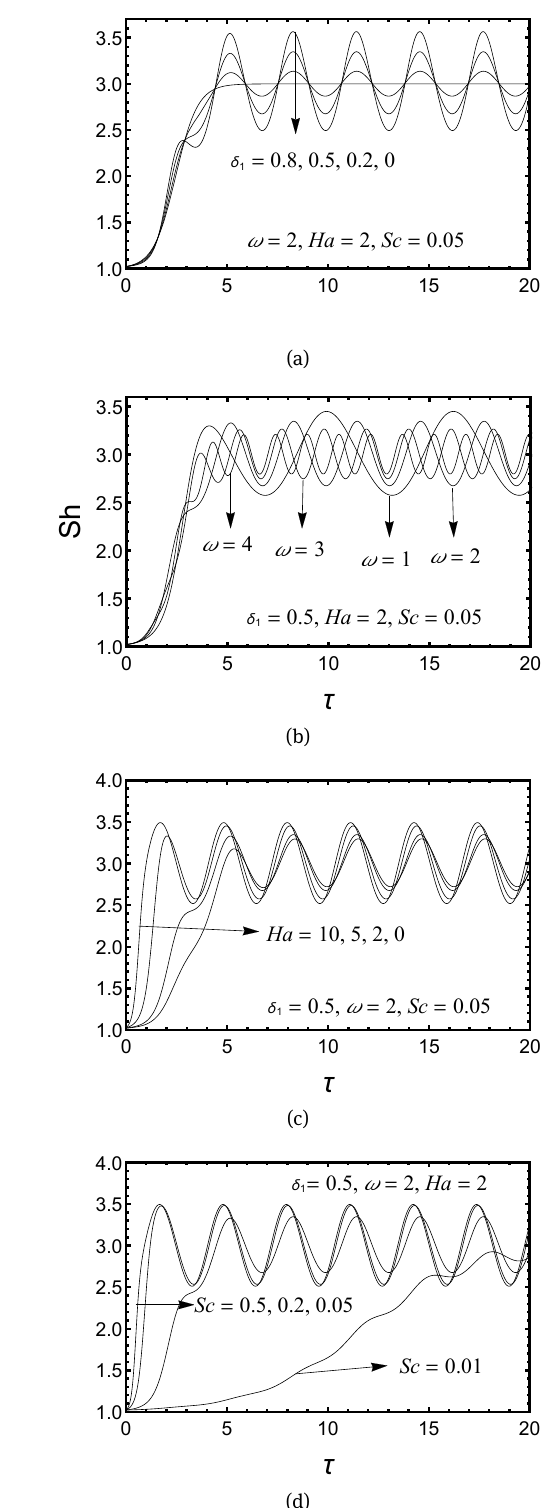
Fig. 2: Variation of Sherwood number Sh with time τ for out phase concentration modulation for different value of (a) δ 1 , (b) ω , (c) Ha , (d) Sc .